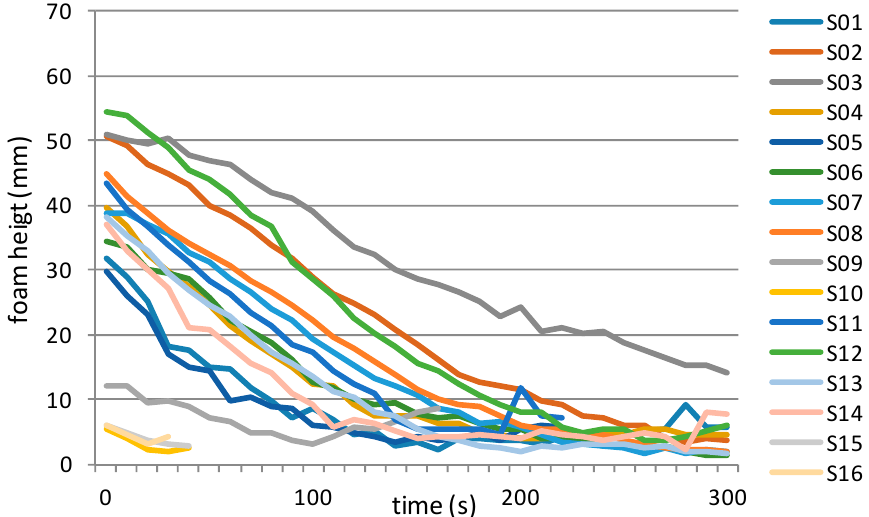
Figure 8. Graphic representation of the foam height determined by laser distance meter.